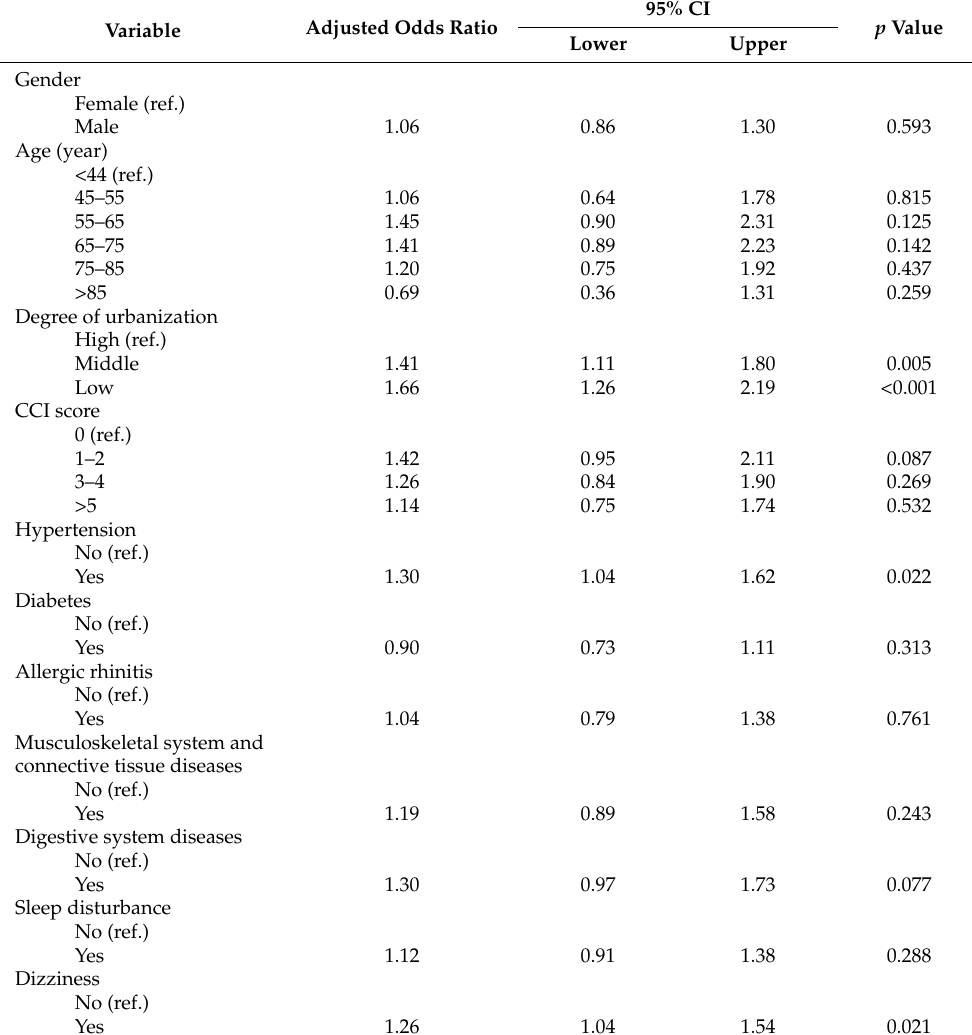
Table 2. Factors related to the willingness of high frequent users of outpatient services to participate in the plan of pharmaceutical home